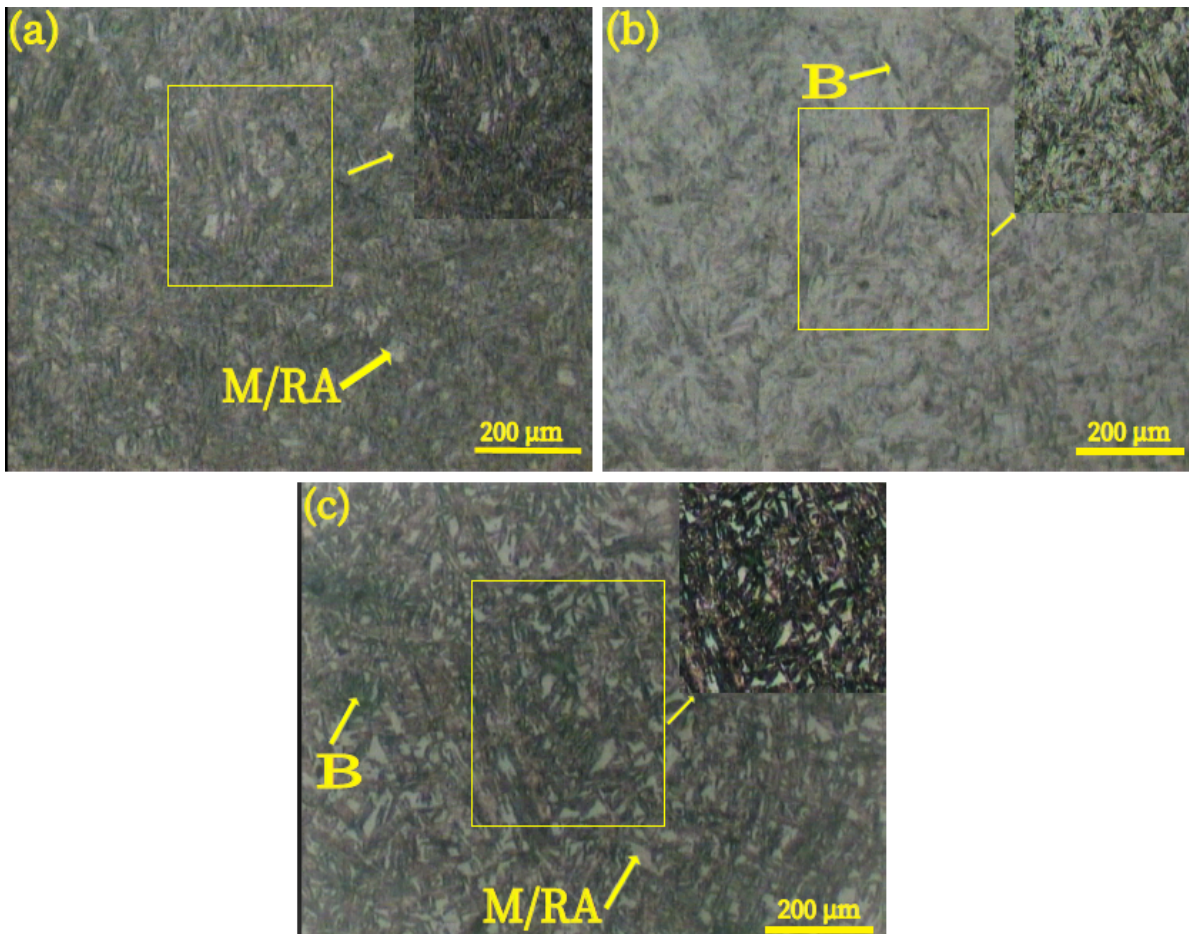
Figure 2. Optical micrographs of Q&B specimens etched in ( a ) 2% nital; ( b ) Vilella’s; and ( c ) Marble’s etching reagents. The bainite (B) and martensite/retained austenite islands (M/RA) are indicated with arrows.